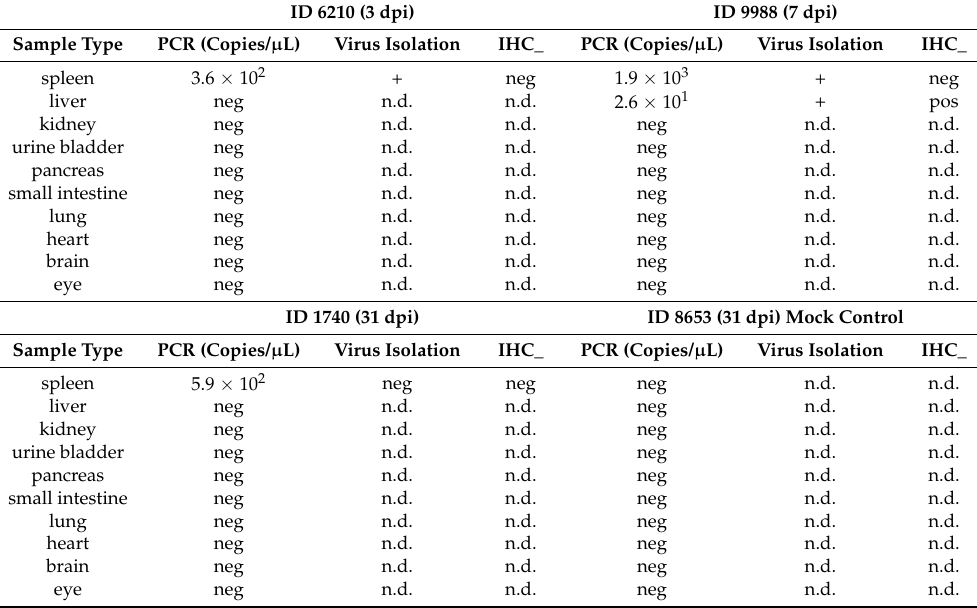
Table 1. Results of qRT-PCR analysis of tissues from MP-12 inoculated Rousettus aegyptiacus fruit